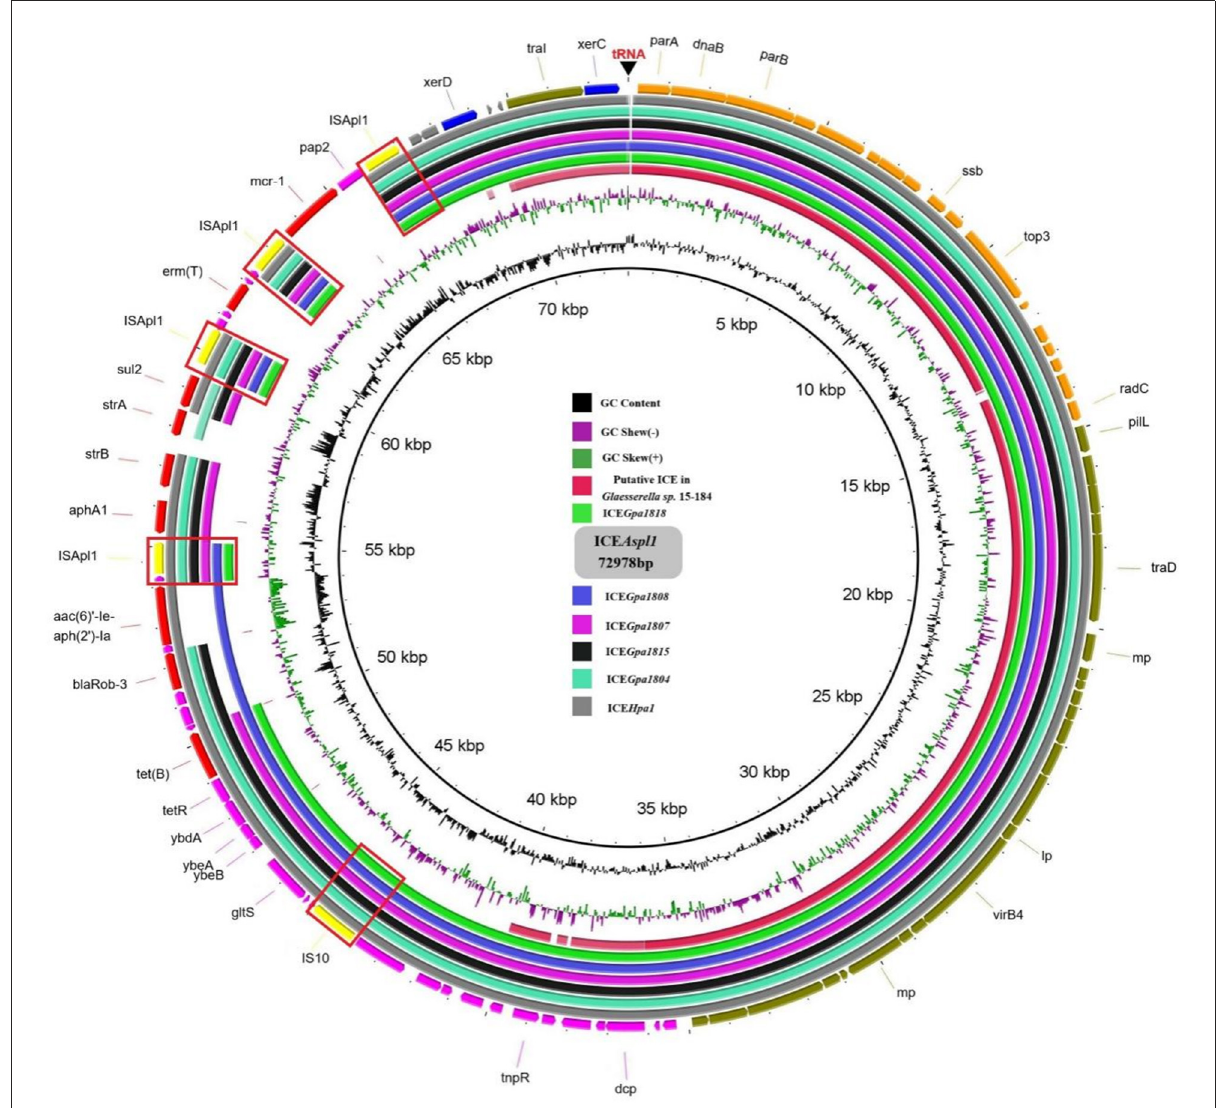
FIGURE4 Comparison of the circular form of the ICE Hpa1 family ICEs. The outer ring comprises the coding sequences (CDSs) of the ICE Asp1 . Circular form of the ICE Asp1 was used as a reference to compare with the the putative ICE in Glaesserella sp .15-184 (CP023057), ICE Gpa1818 (CP071487), ICE Gpa1808 (CP071490), ICE Gpa1807 (CP071491), ICE Gpa1815 (CP071489), ICE Gpa1804 (CP069308), and ICE Hpa1 (CP054198). Key features of the ICE Asp1 are highlighted in different colors, replication genes and stability-associated genes are in orange, transfer-associated genes are in olive, IS elements are in yellow, ARGs are in red, other genes are in purple and integrase genes are in blue. IS elements were marked by the